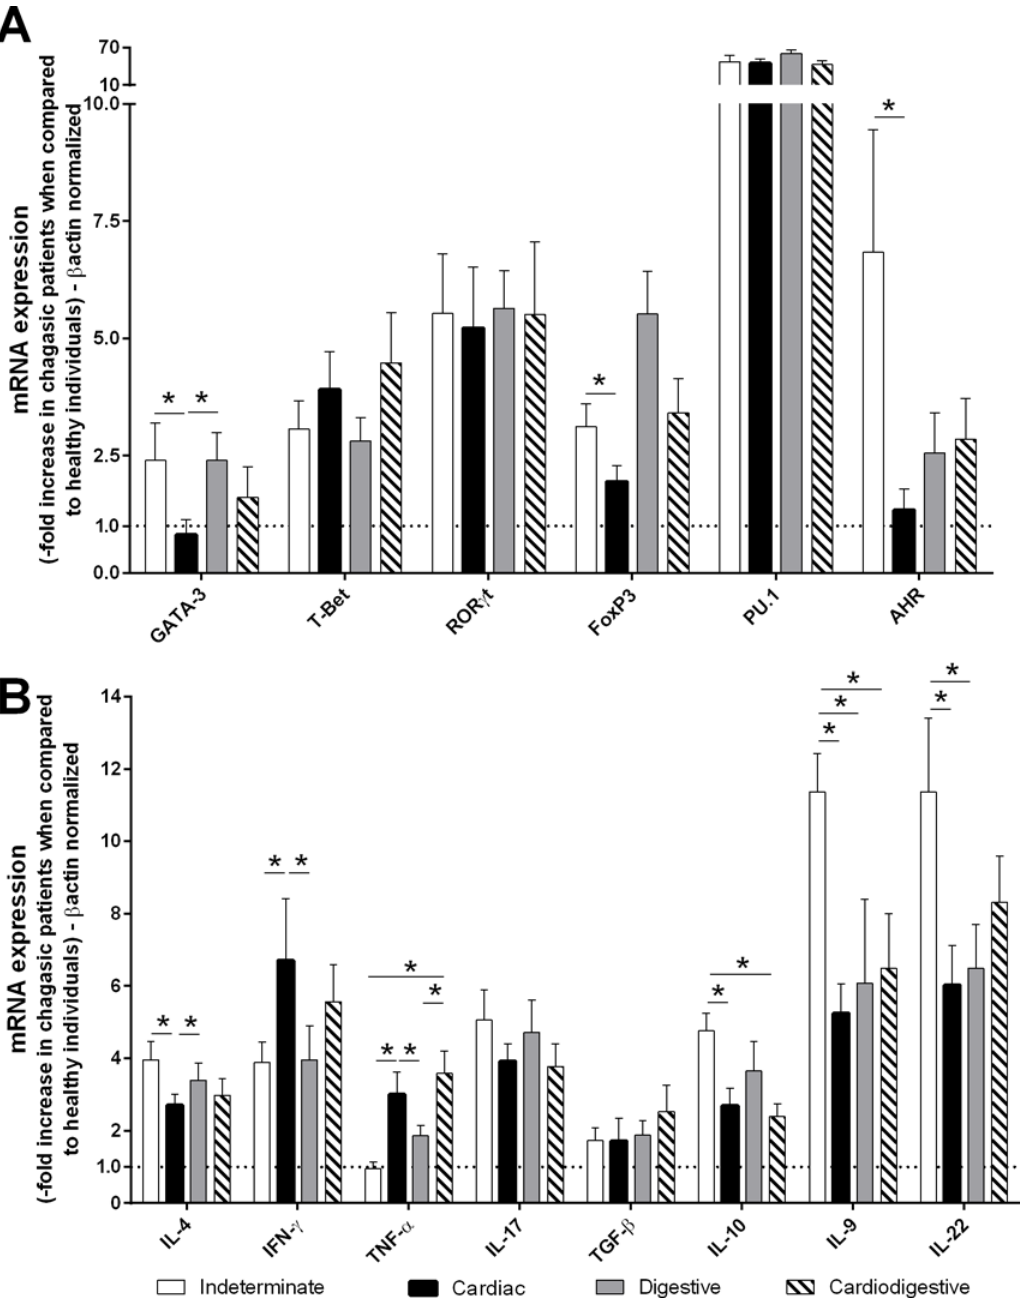
Fig 1. Indeterminate patients exhibited higher GATA-3, Foxp3, AHR, IL-4, IL-9, IL-10, and IL-22 mRNA expression than did cardiac patients. The mRNA expression levels of transcription factors (A) and cytokines (B) were determined by real-time PCR in peripheral blood mononuclear cells of patients with the indeterminate (n = 18), cardiac (n = 17), digestive (n = 15) and cardiodigestive (n = 15) clinical forms of Chagas disease. The expression levels were normalized to the expression level of β -actin . The results are expressed as the means ± standard errors. * P <